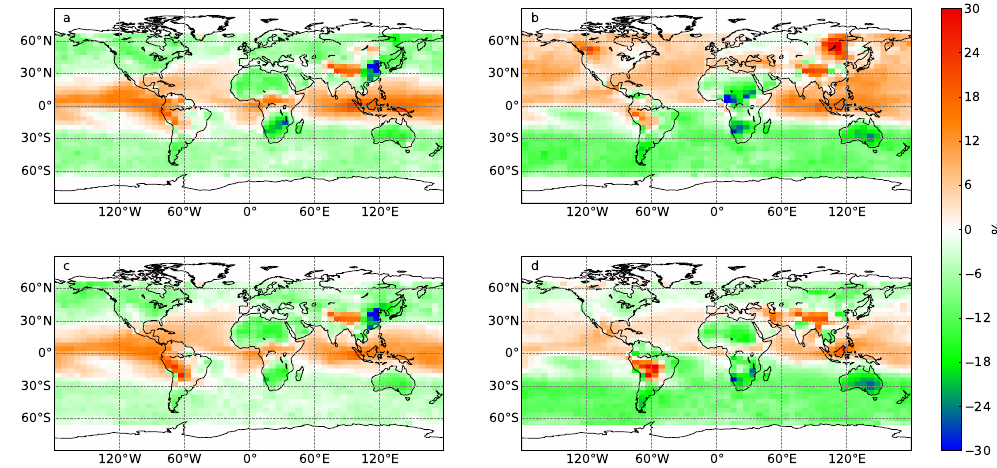
Fig. 5. Annual difference in CO total column, TM5-MOPITT relative to TM5 (%) for the years 2003 (top) and 2004 (bottom). Modeled CO total columns are derived using the prior (left) and posterior (right) emissions. Reddish colors indicate higher TM5 CO total columns compared with MOPITT and greenish colors indicate a lower modeled CO total column compared to